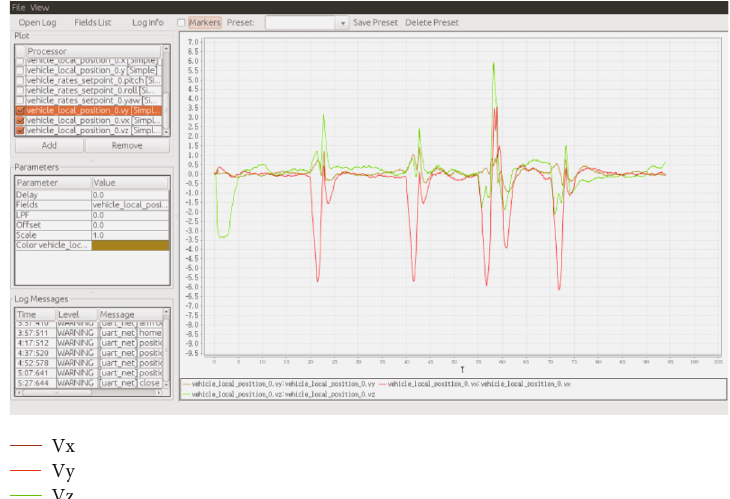
Figure 18: Movement speed of the